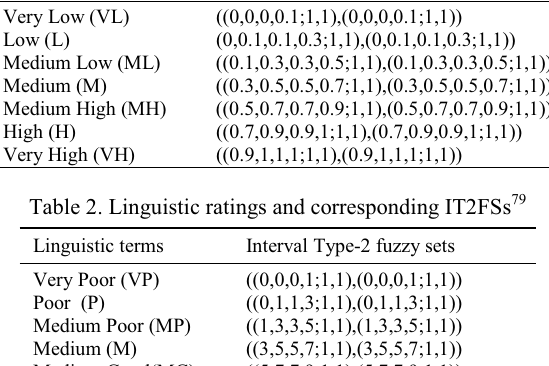
Linguistic terms